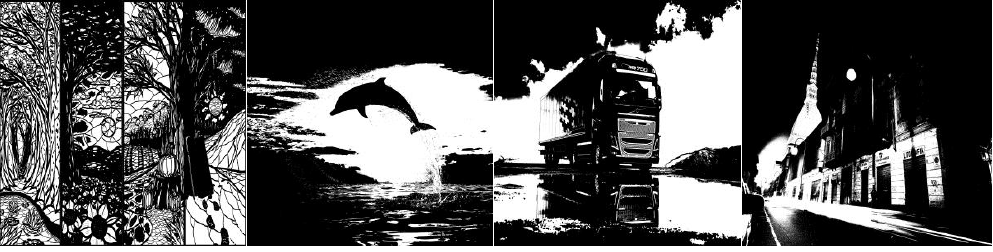
Figure 9. Image samples from the GF datasets.